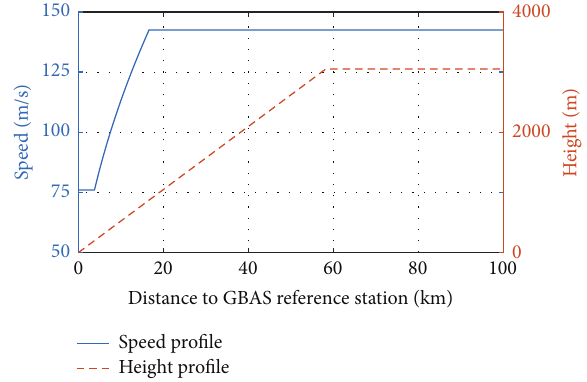
Figure 7: Speed and height profile used for protection level